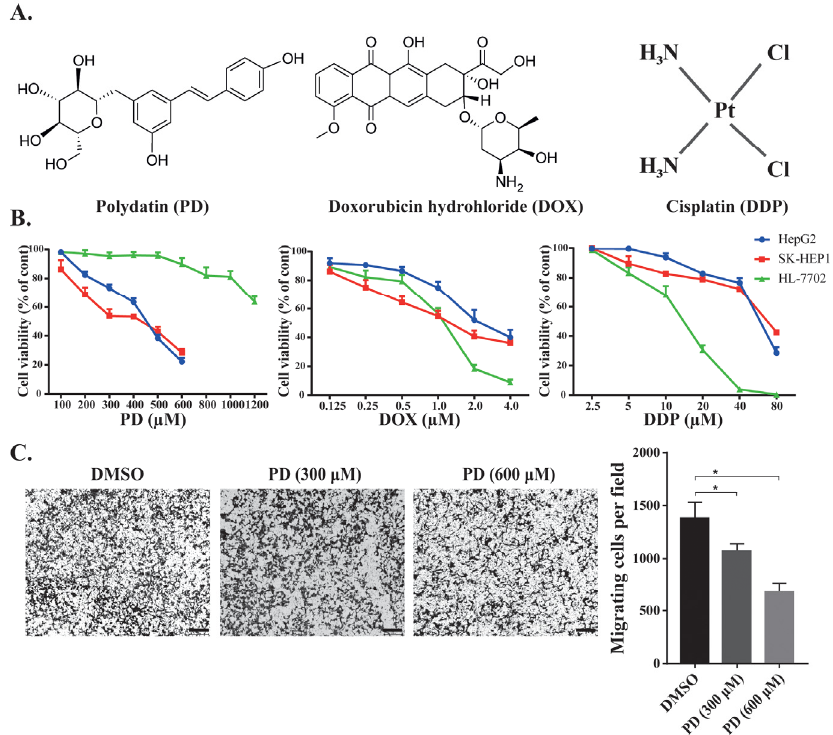
Figure 1. Effects of chemotherapeutic agents in HCC and in normal cell lines. ( A ) Illustration of the chemical structures of PD, DOX and DDP. ( B ) Cell viability of the normal liver HL ‐ 7702 cells and HCC HepG2 and SK ‐ HEP1 cells when treated by PD, DOX and DDP. The cells were treated with different concentrations of the chemicals for 48 h, followed by WST ‐ 1 assays to evaluate cell proliferation and calculation of cell viability. ( C ) Evaluation of PD’s effects on HepG2 cell migration. HepG2 cells in the transwell were treated by DMSO, 300 and 600 μ M of PD for 48 h, followed by staining using crystal violet. Representative images are shown on the left, and the quantitative data from three separate experiments are shown on the right. The scale bar in each image is 100 μ m. * as p < 0.05.